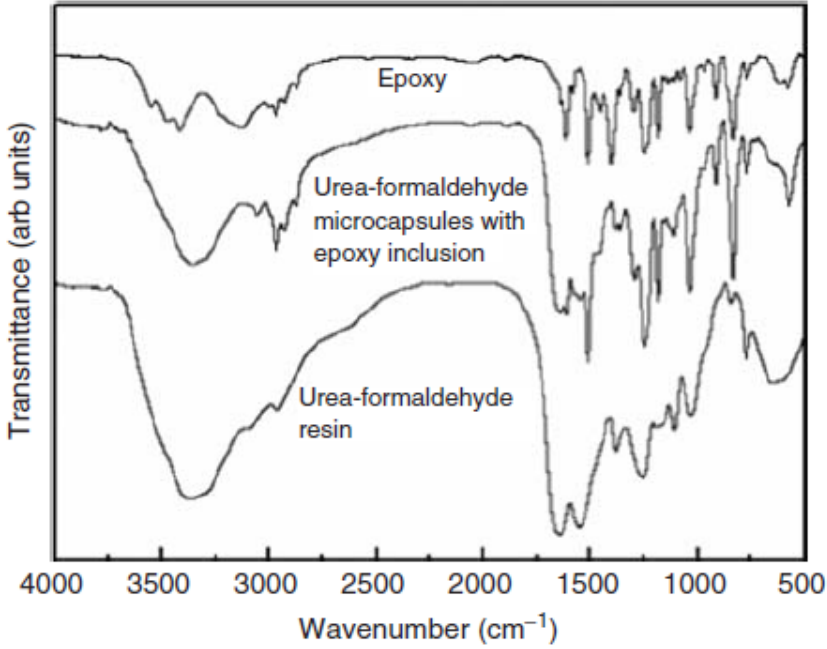
Figure 18. FTIR spectra of epoxy, epoxy filled in urea – formaldehyde capsules, and resin [6].